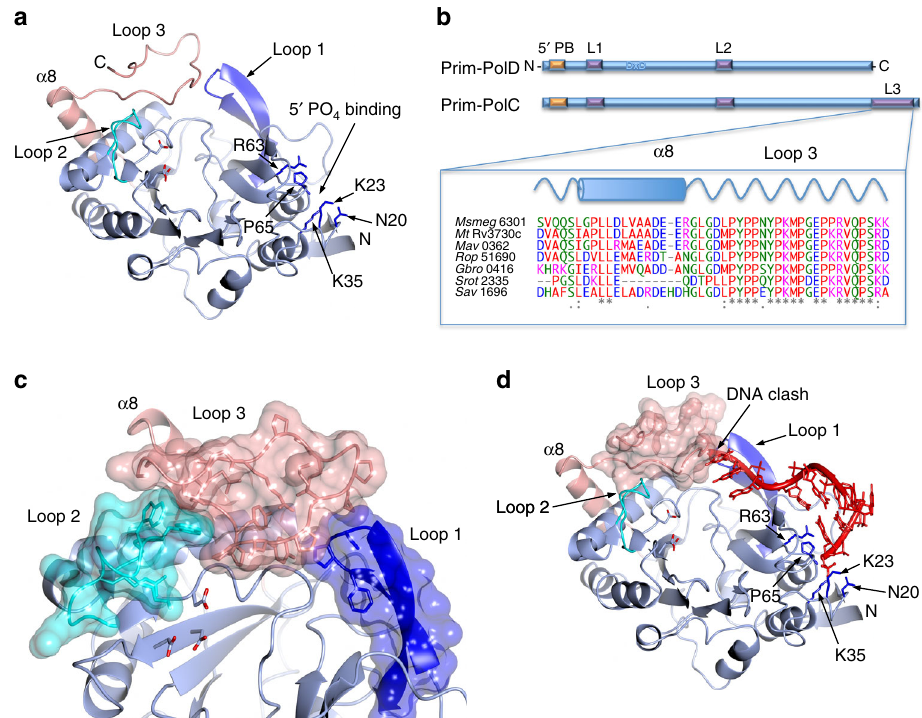
Fig. 5 Crystal structure of Prim-PolC. a A ribbon diagram representation of the crystal structure of Prim-PolC (PDBID: 5OP0). The previously characterised NHEJ Prim-Pol core is coloured sky blue (Fig. S6a), with the conserved loop structures from this family coloured dark blue and cyan for Loops 1 and 2, respectively. The catalytic aspartate side-chains are represented with the carboxylic oxygens shown in red. Side-chains involved in forming the 5 ′ phosphate binding pocket are depicted in dark blue. The Prim-PolC speci fi c C-terminal extension is shown in pink, comprising α 8 and Loop 3. b Schematic representation comparing the primary structures of Prim-PolD and Prim-PolC. Conservation of the C-terminal extension of Prim-PolC among selected organisms are highlighted by a sequence alignment of this region. c Ribbon diagram representation of the Prim-PolC crystal structure highlighting the molecular contacts formed between the conserved loops (1 and 2) and the additional Loop 3. The loops are further represented as translucent solvent accessible surfaces colour matched to the speci fi c loop element. d Superposition of DNA from the NHEJ Prim-PolD MMEJ complex (PDBID: 4MKY) onto the Prim-PolC structure. The path of the templating DNA from the in-trans structure clashes with Loop